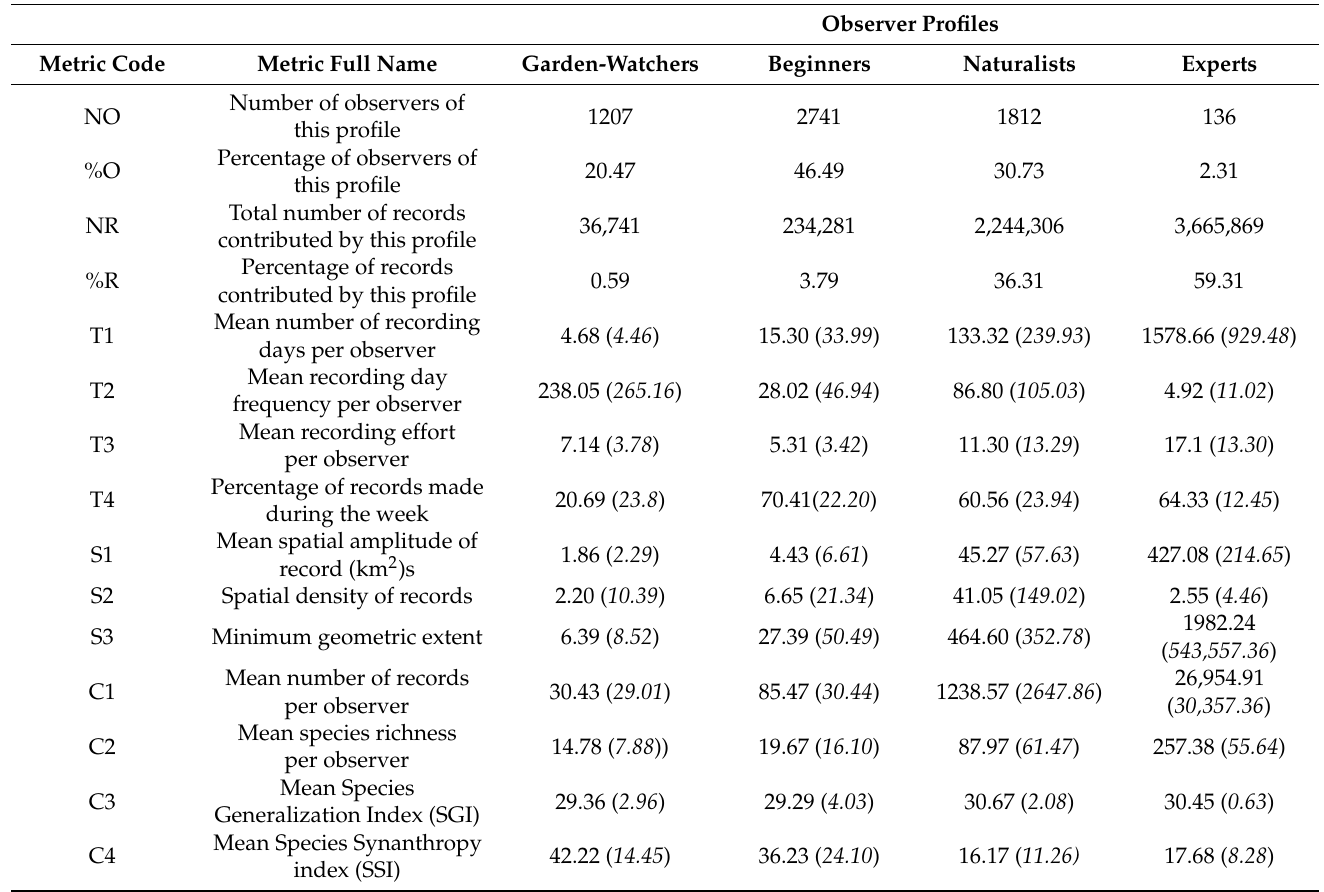
Table 2. A summary of variation in metrics between observer profiles across the dataset as a whole. N.B. All 15 years of data over the entire region are pooled in this analysis. When mean is given, standard deviation is added as ( sd